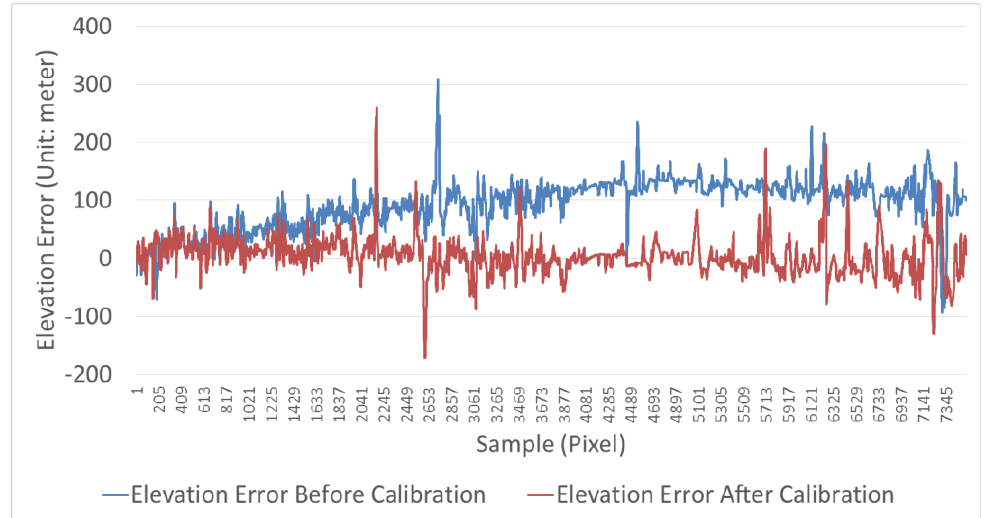
Figure 10. Elevation error before and after calibration.